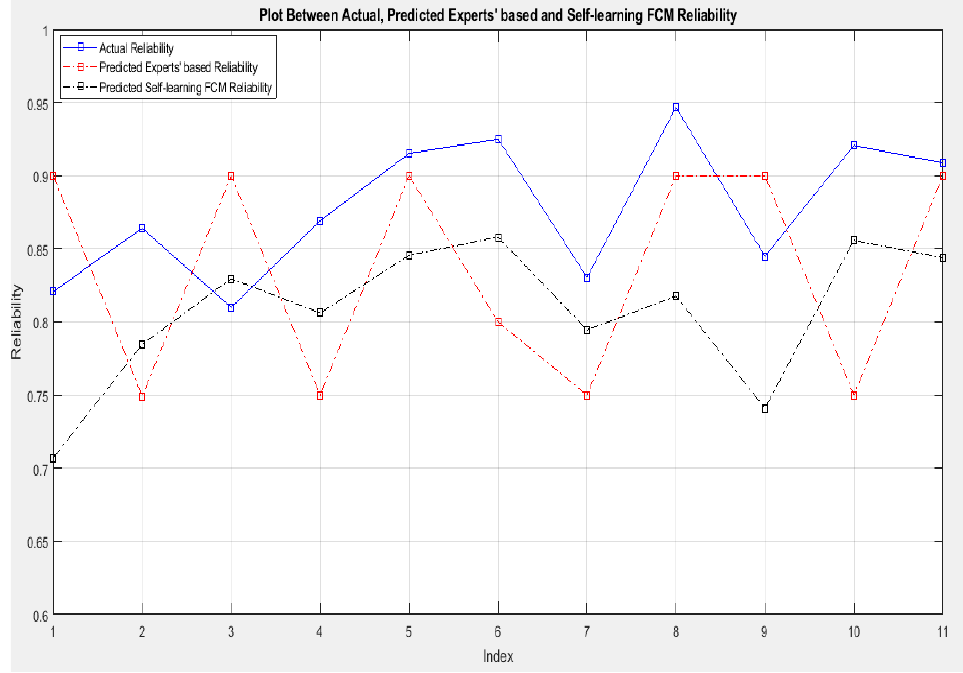
Figure 7. Plot of actual reliability, predicted experts’-based reliability, and self-learning FCM reliability. Table 2. Results summary predicted reliability and actual reliability.